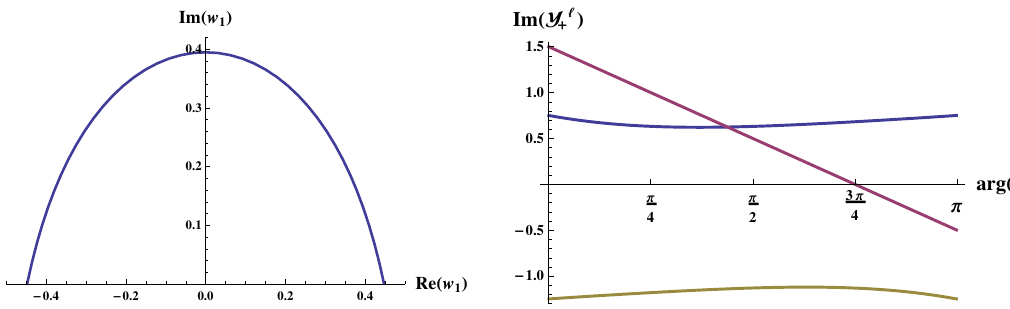
Figure 3 . On the left hand side the allowed locations for the branch point w 1 in the upper half plane, for the solution (4.7) with a single puncture corresponding to a D7-brane and n 1 = 1. On the right hand side the imaginary part of the charges along the curve shown on the left. At arg( w 1 ) = (cid:25) the curves are, from top to bottom, Im ( Y 1